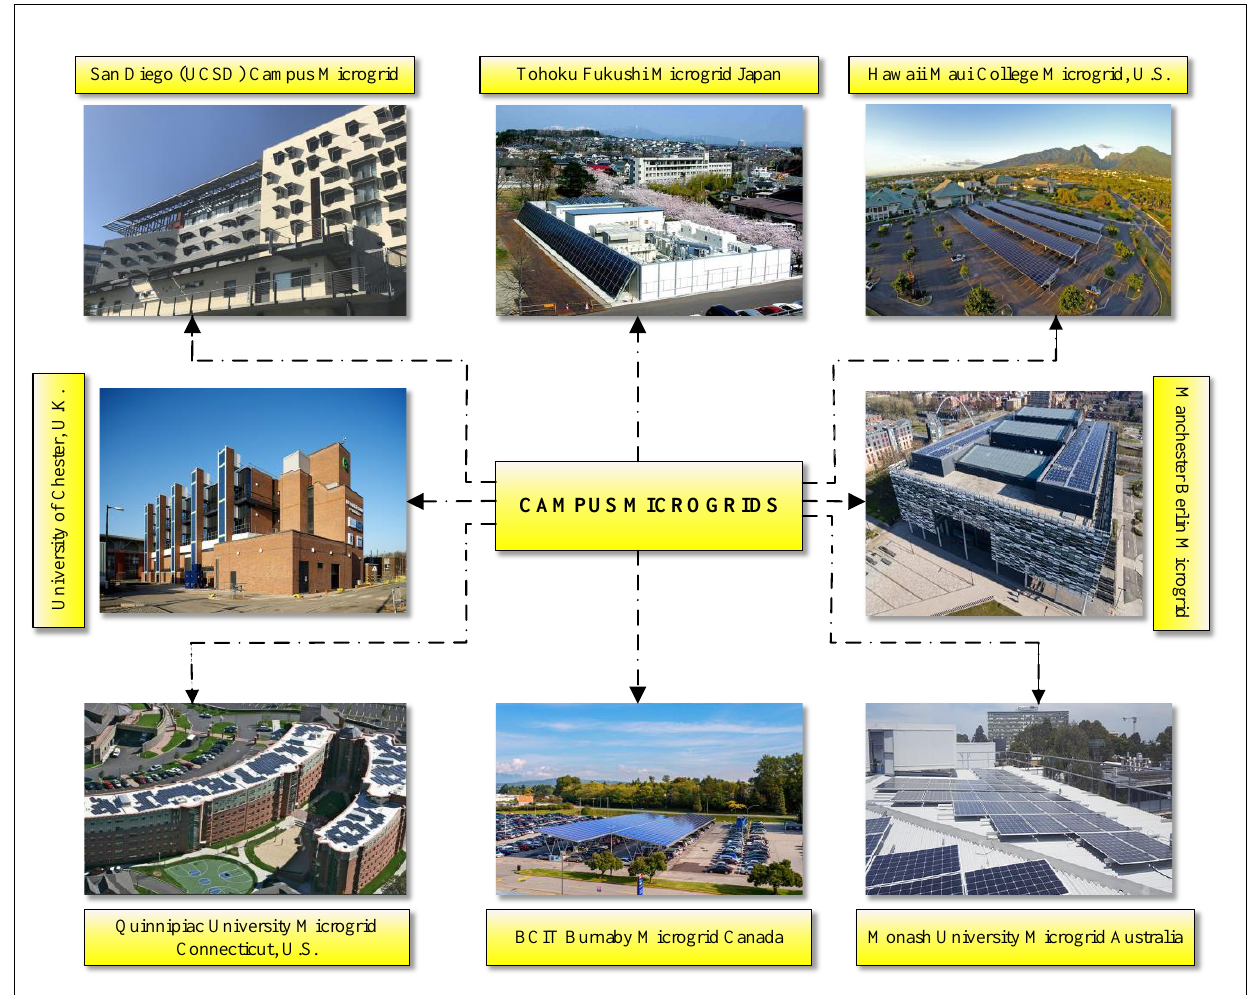
Figure 2. Overview of campus microgrids at different locations.